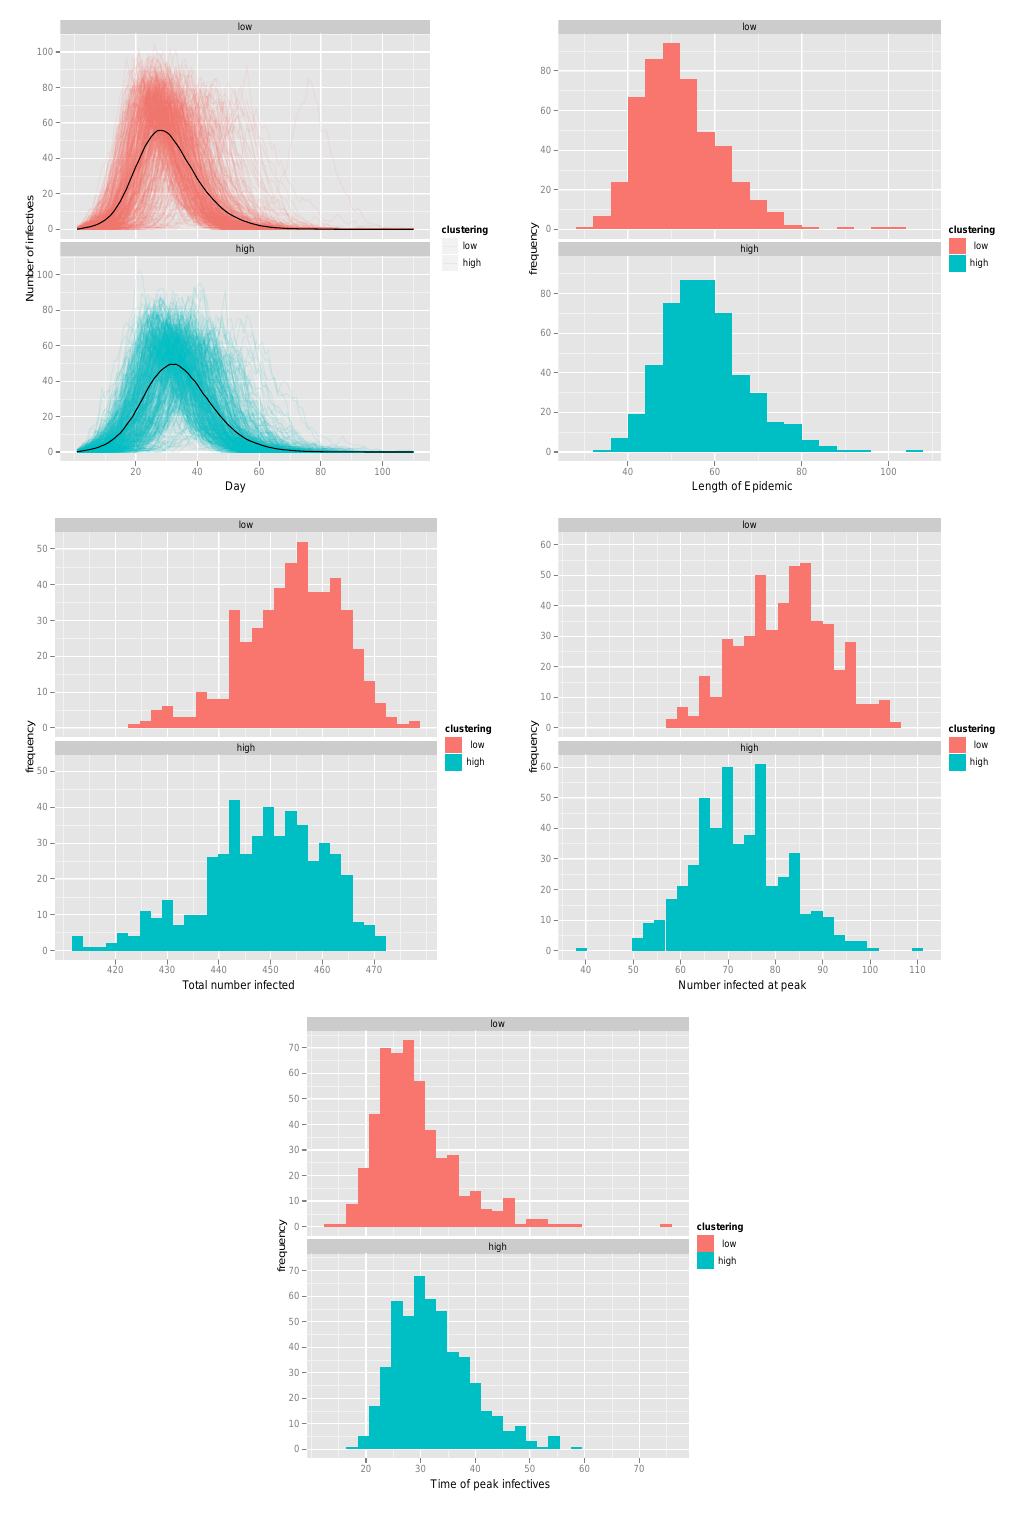
Figure 4. Empirical distributions of summary statistics for epidemics on Bernoulli networks. (top left) Number of infected individuals through time with daily mean shown in black; (top right) Length of epidemic; (centre left) Maximum number infected at peak of outbreak; and, (bottom) Time of outbreak